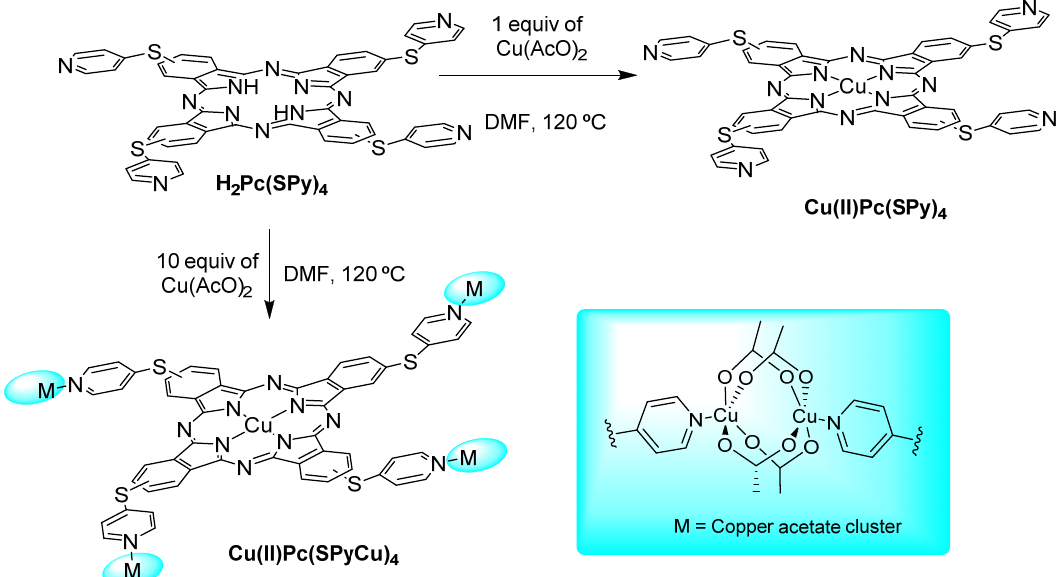
Figure 35. Schematic synthetic pathway to obtain the metallophthalocyanine Cu(II)Pc(SPy) 4 and the Cu(II)Pc(SPyCu) 4 polymeric material, starting from H 2 Pc(SPy) 4 (adapted from [84]).